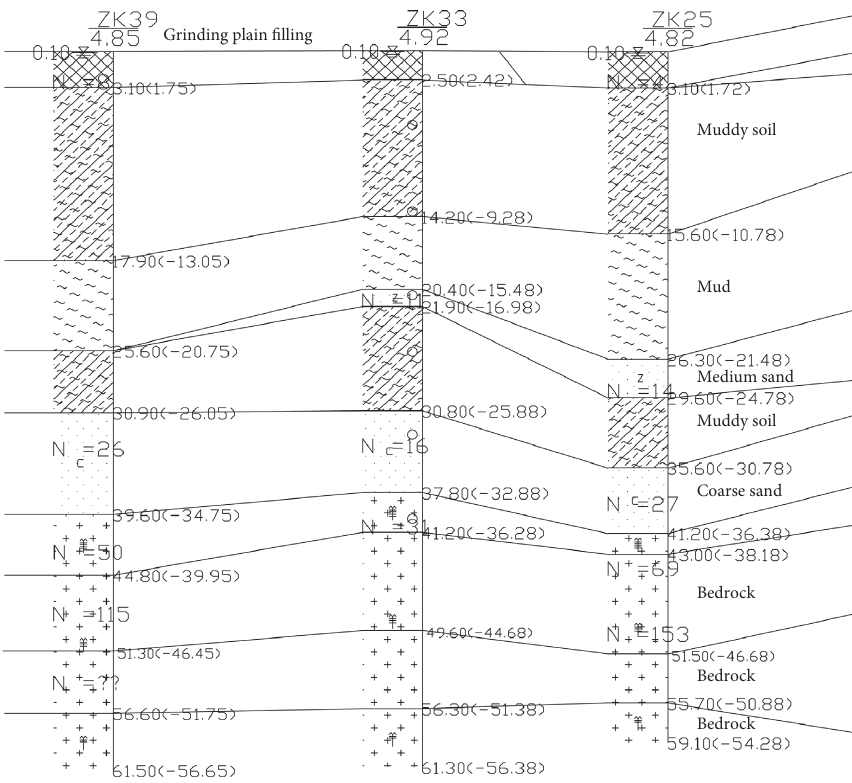
Figure 1: The stratigraphic texture of the experimental site.